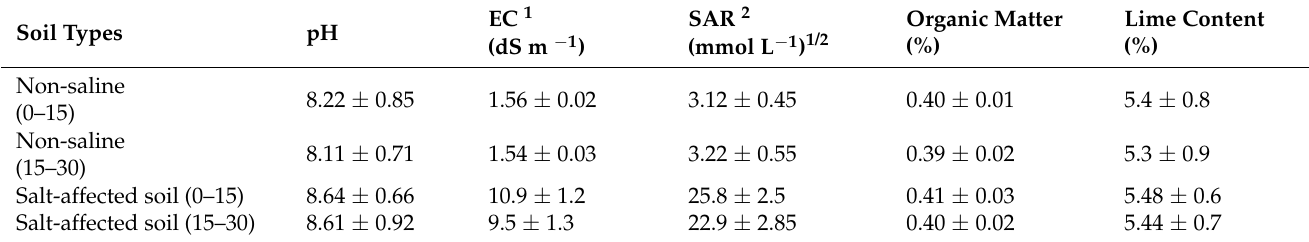
Table 4. Properties of normal (non-saline) and salt-affected soils used in the